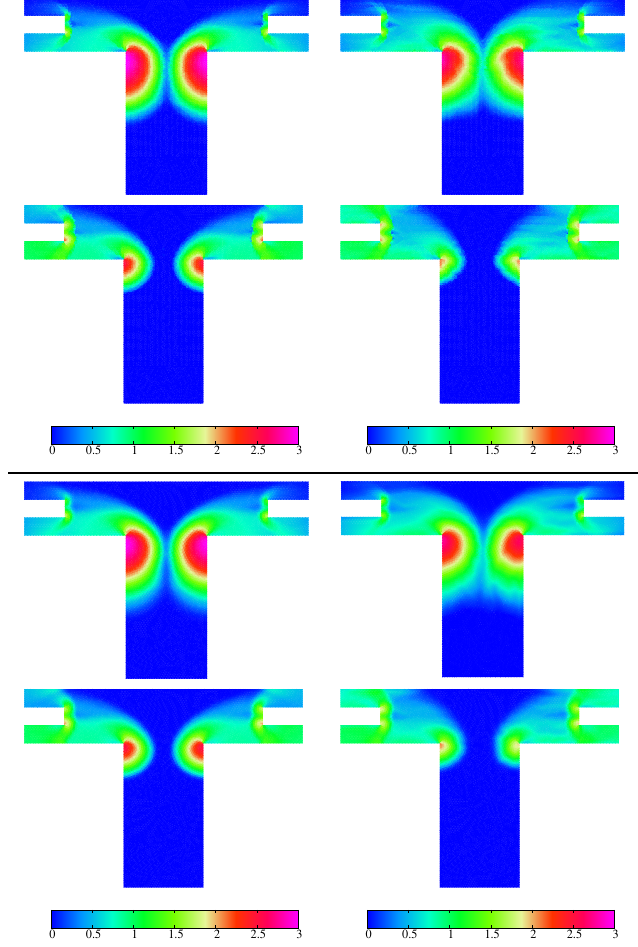
Figure 11. T-shape domain, FV(BR), FV(DA) ( top ) and FV-DG(BR), FV-DG(DA) ( bottom ). Density distribution obtained on the finest meshes at time t = 9,15